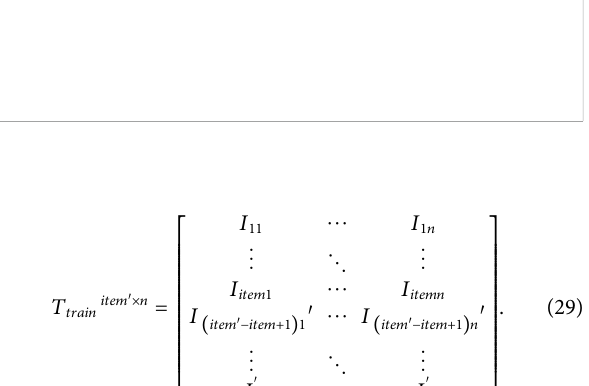
FIGURE 4 Architecture of the proposed deep learning